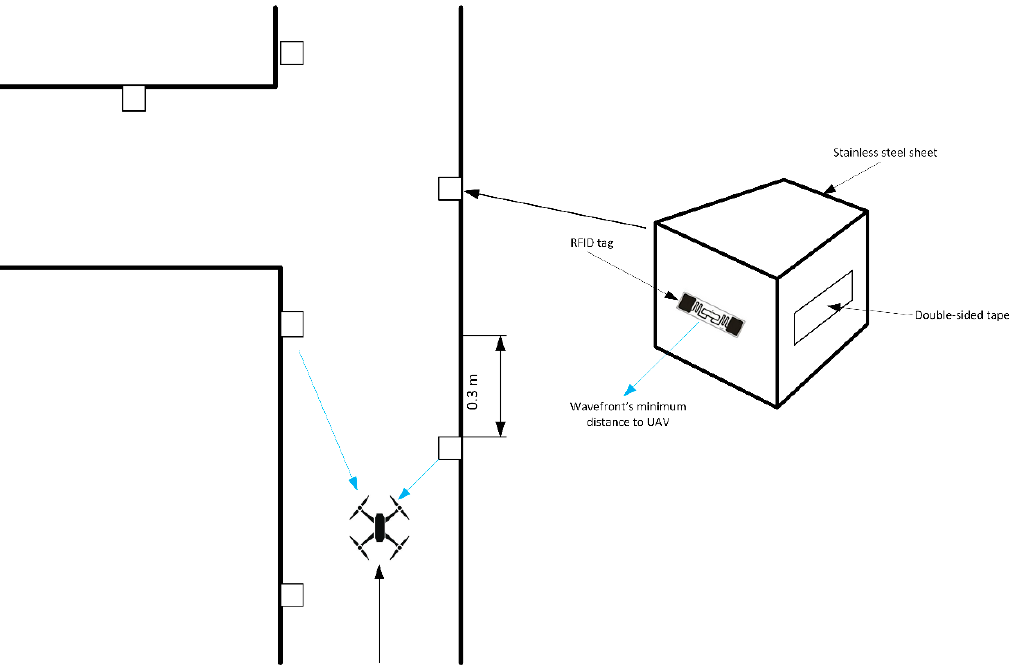
Figure 3. Plan view of confined flying corridor, showing location of RFID passive tags for positioning.